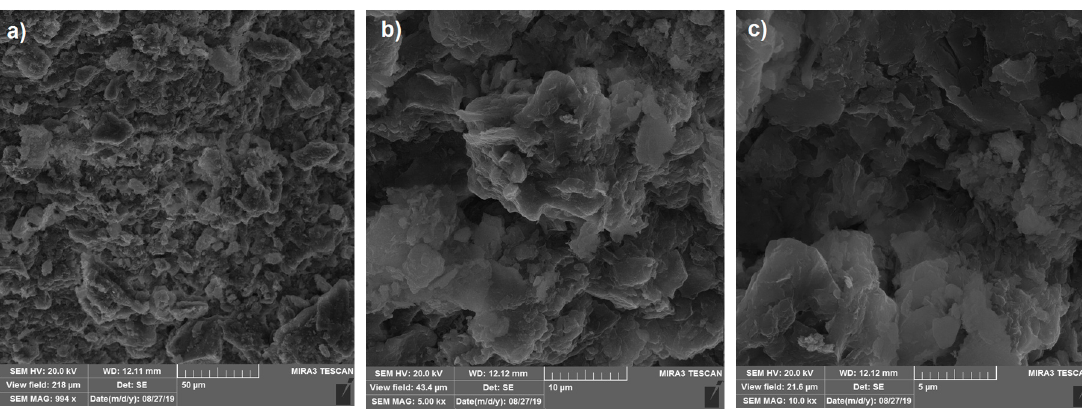
Figure 2. SEM micrographs of slag measured with different magnifications: ( a ) 994×, ( b ) 5000× and ( c ) 10000×.